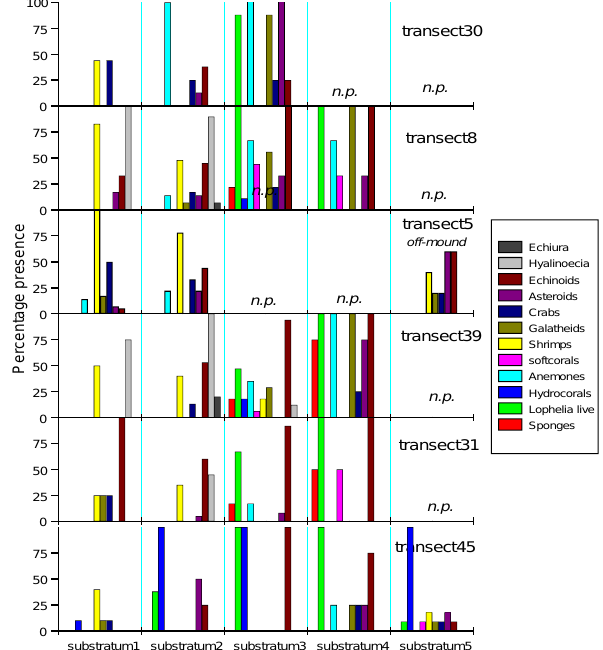
Fig. 5. Faunal assemblages of the video transects for each of the five recognised substrata (1=soft sediment, 2=sediment partly to densely covered with coral rubble and/or dead framework, 3=well- developed (3-D) but predominantly dead framework with scat- tered live branches, 4=well-developed framework with coalescent live branches, 5=stones/hard rock). The abundance of each faunal group is indicated as a percentage of presence at the 50m sections of the whole video transect. The locations of the transects are indi- cated in Fig.